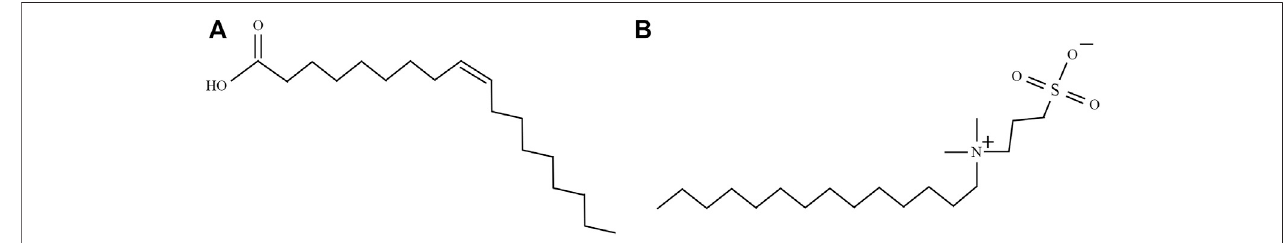
FIGURE 1 | Structural formulae of two kinds of surfactants: (A) oleic acid (OA) and (B) 3-(N,N-dimethylmyristylammonio)propanesulfonate (DP).